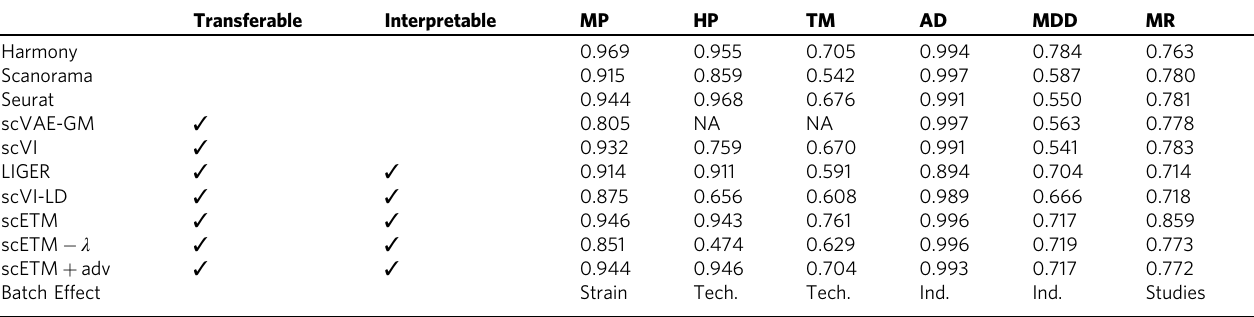
Table 1 Model properties and unsupervised clustering performance on data integration